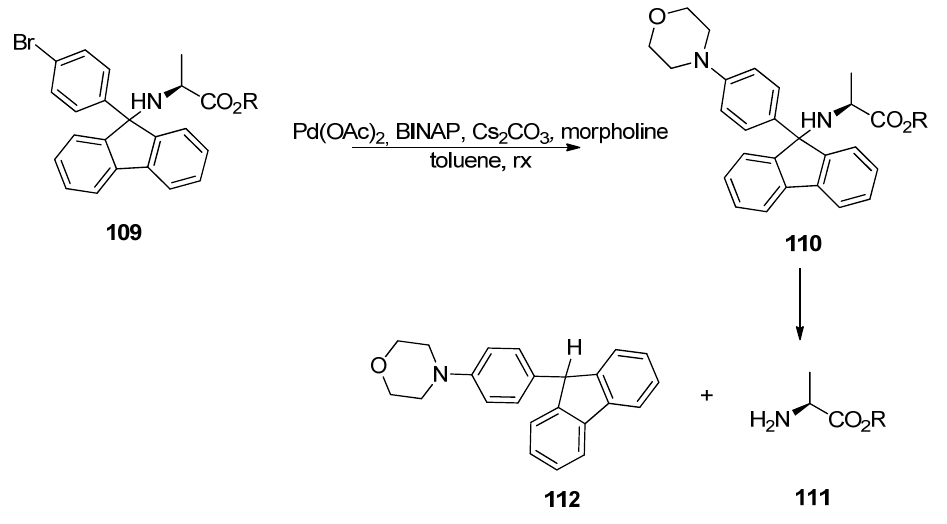
Scheme 36. Palladium-catalyzed cross-coupling in the removal of